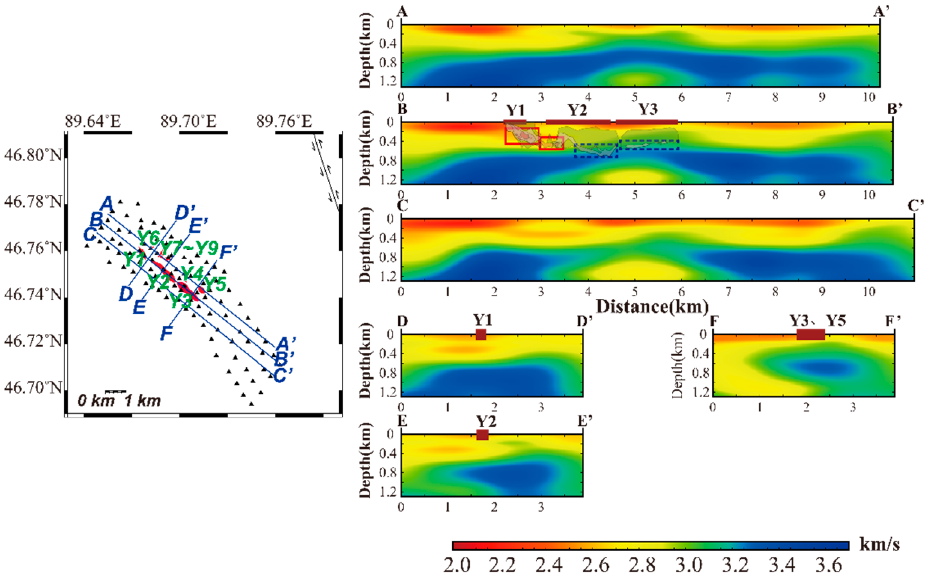
black dotted lines at 0.1~0.7 km in the lower panel all show ore hosting intrusions. Red solid rectangles represent LVZs at Y1 and northwest of Y2. Blue dotted rectangles indicate HVZs southeast of Y2 and Y3. Right panel represents horizontal slices of shear wave velocity in the mine at the depth of 0.2, 0.3, 0.4, 0.6, 0.85 and 1.3 km (a-f). Areas circled by blue lines on the upper panel and yellow lines on the bottom panel are the ore-hosting intrusions Y1~Y9 in Karatungk mine.